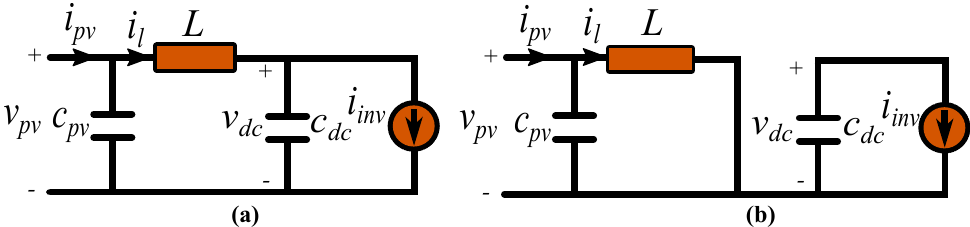
Figure 3. Equivalent circuit of the boost converter when: ( a ) switch is OFF, and ( b ) switch is ON. ˙ x = A x + B u , y = C x + D u ,